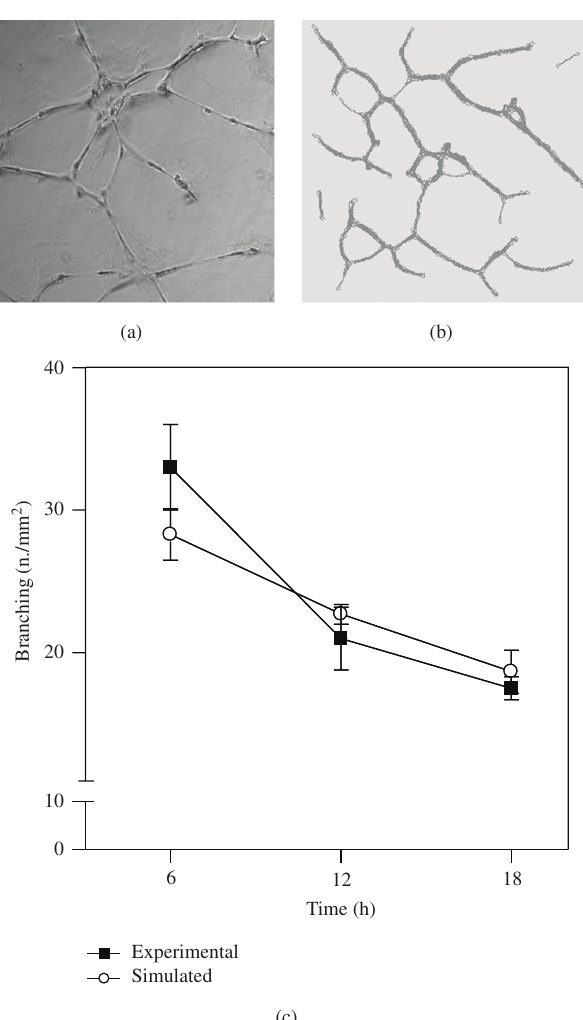
FIGURE 3: (a) Phase contrast micrograph illustrating the arrangement of human endothelial cells (HUVECs) into a meshwork of capillary-like tubular structures when cultured on Matrigel for 18 hr. (b) Typical patterns generated by a CPM tuned to simulate the in vitro organization of the cells after 18 hr of culture. (c) Number of branching points over time (see [57, 59]) for in vitro and in silico capillary-like patterns illustrating that the time course of pattern formation by HUVEC is well captured by the